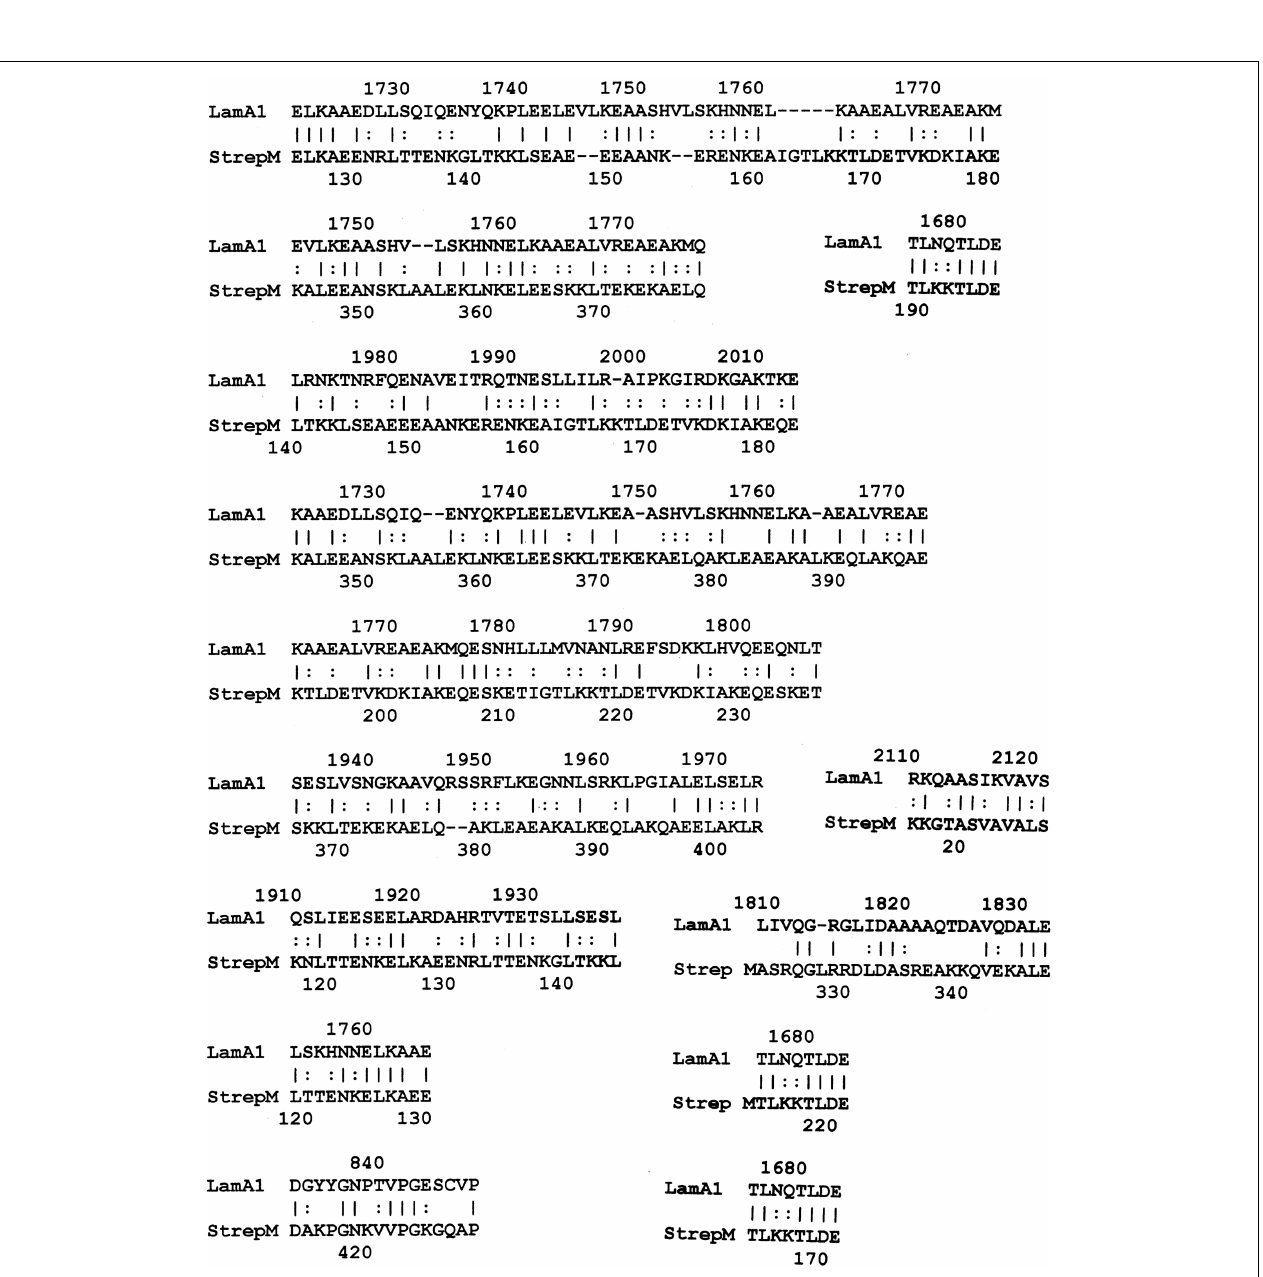
FIGURE 3 | Results of LALIGN similarity search comparing groupA streptococcal M protein (P08089) to human laminin alpha 1 (P25391)